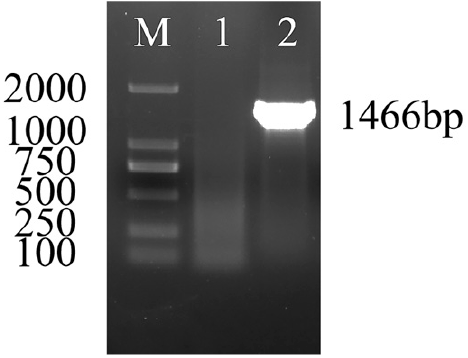
Figure 2. Results of 16S rRNA amplification electrophoresis of K.pneumoniae . “M” represents DL2000 DNA Marker. “1” represents negative control. “2” represents KPHN001 colony (The original gel figure can be found in Supplementary Figure S1).